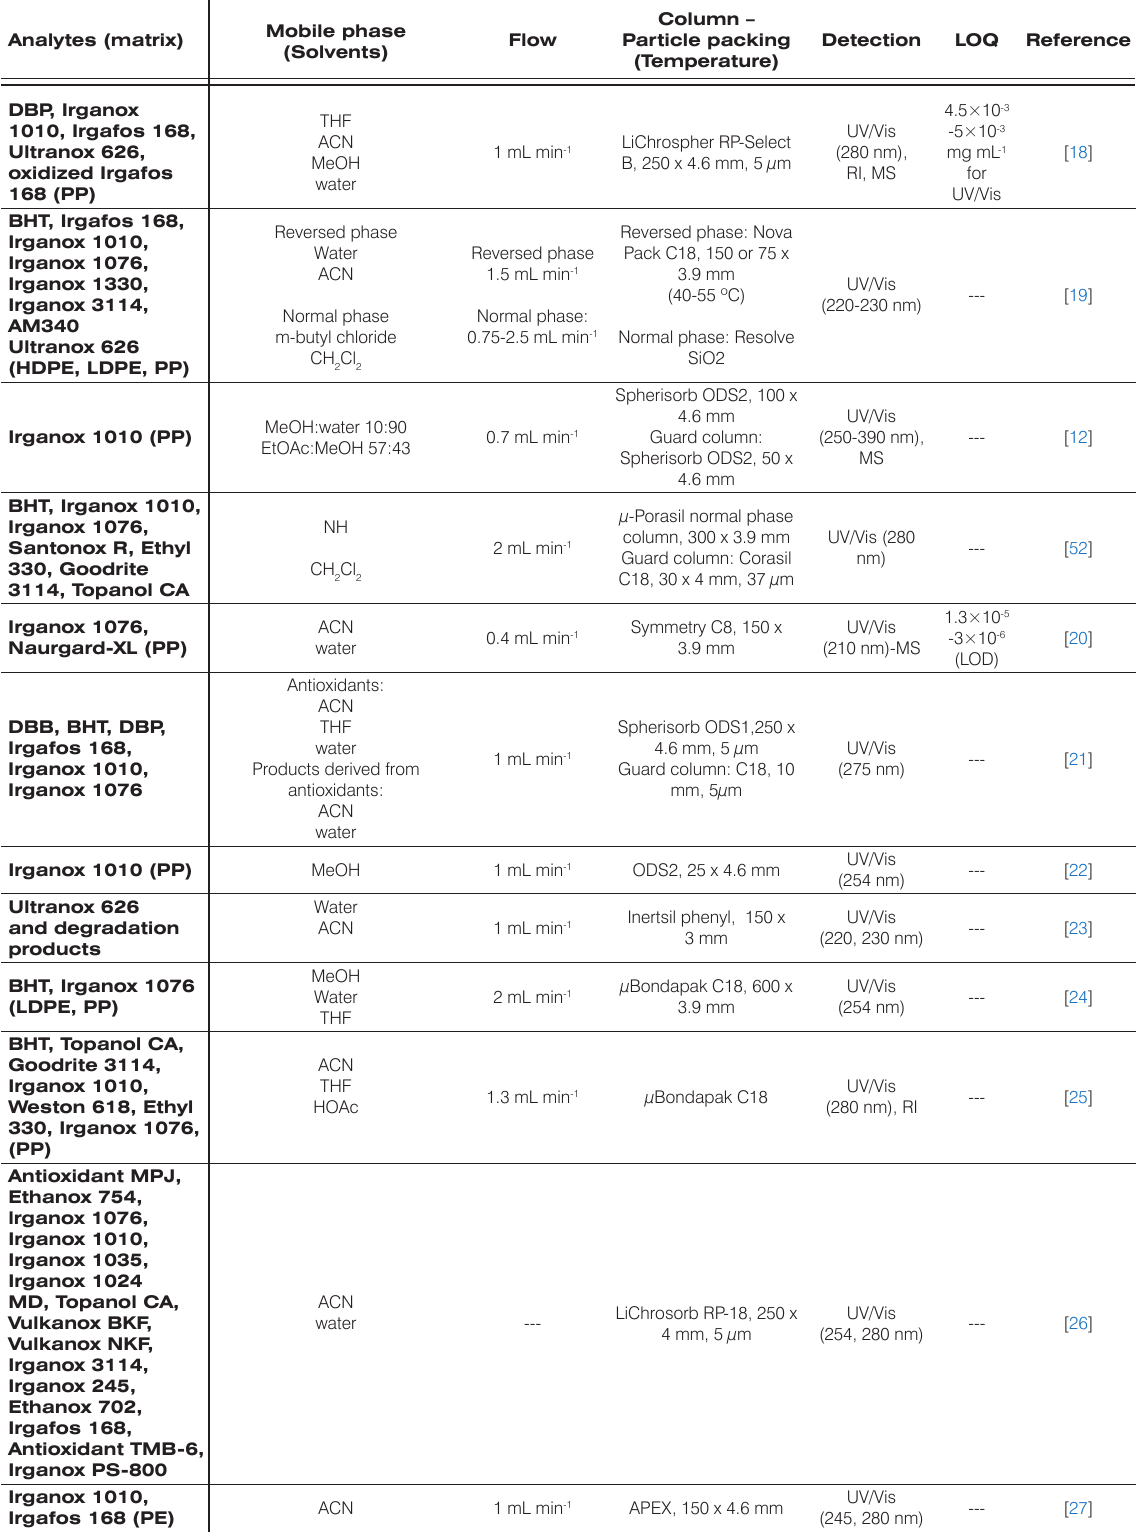
Table 1. Summary of liquid chromatography based methods for the determination of antioxidants in